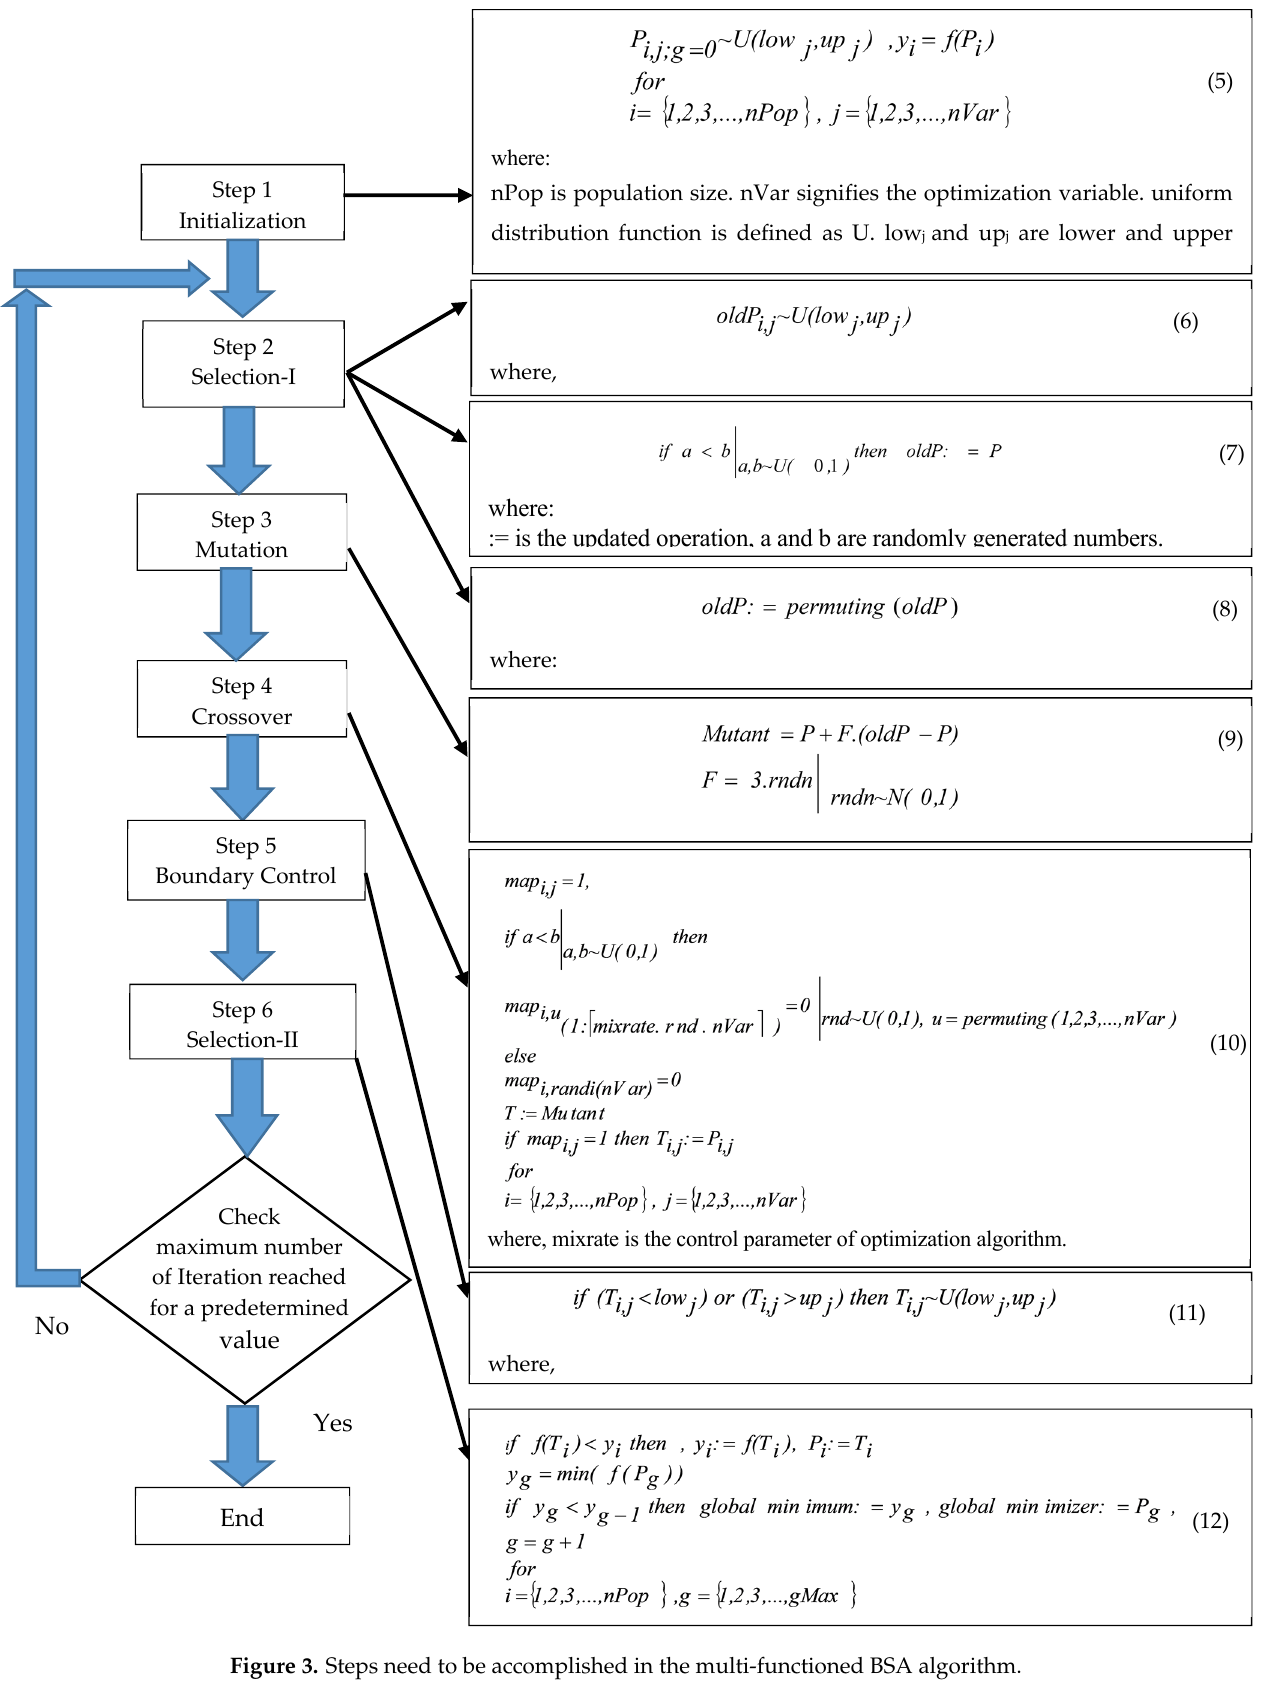
Figure 3. Steps need to be accomplished in the multi-functioned BSA algorithm.